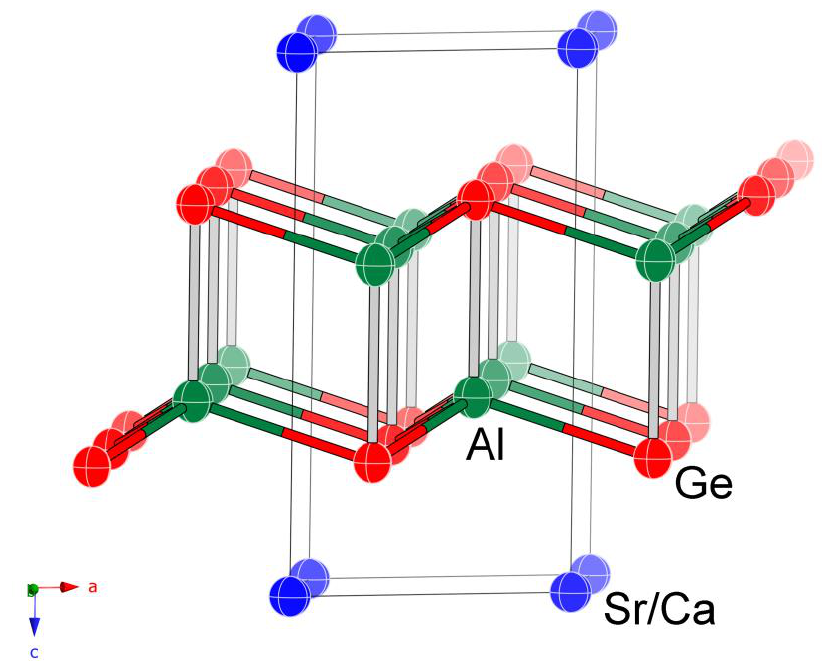
Figure 2. Off [010]-view of the crystal structure of Sr 0.36(1) Ca 0.64 Al 2 Ge 2 , emphasizing the double [Al 2 Ge 2 ] 2 − layers. The three shorter and one longer Al – Ge bonds are represented with different colors. The unit cell is outlined. Thermal ellipsoids are drawn at the 95% probability level.